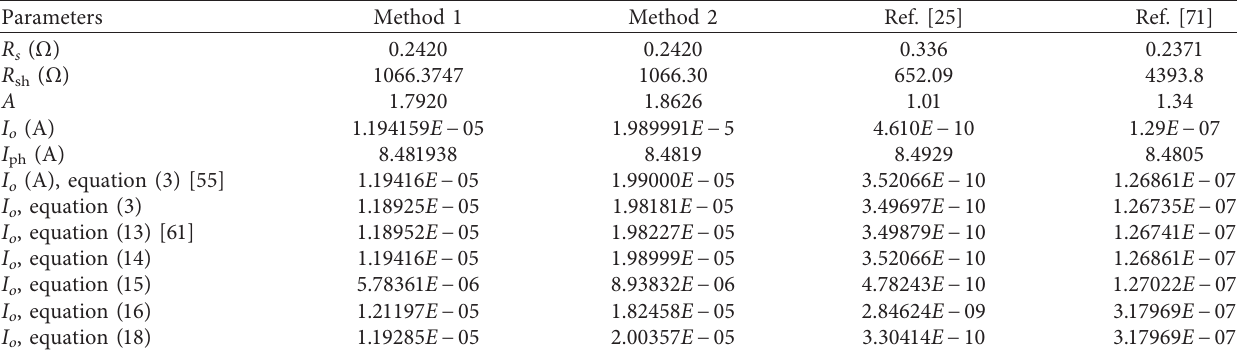
Table 7: Calculated parameters and data from simulations for BP3235T.